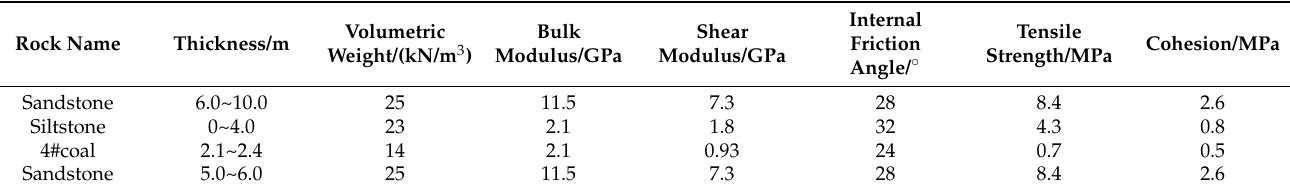
Table 1. Mechanical parameters of the roof and floor footwall and hanging